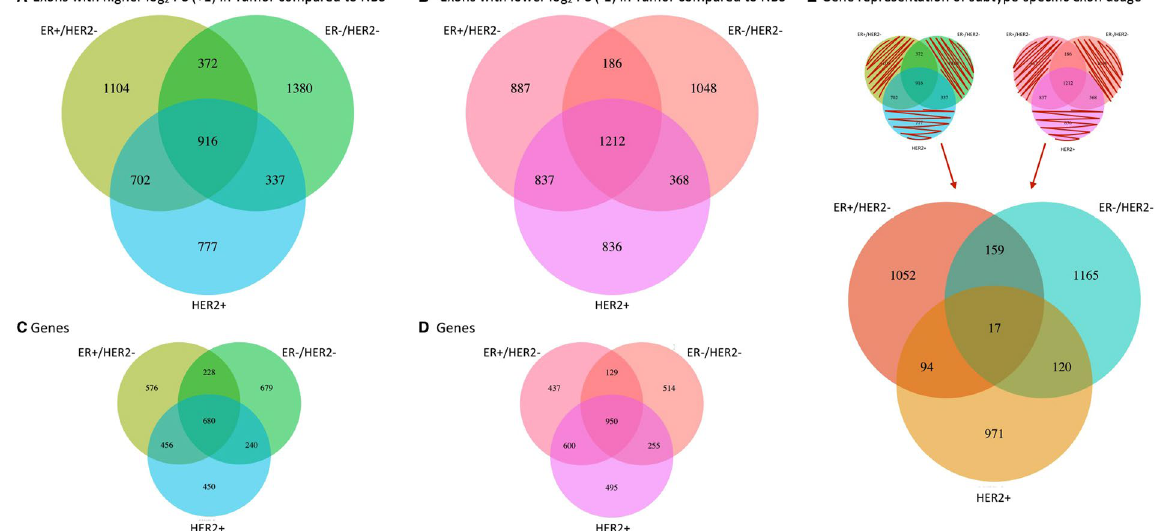
Figure 2. Alternative exon usage in tumor subtypes compared to NBS. The number of exons identified as differentially spliced or transcribed in each tumor class compared to NBS with ( A ) higher FC, and ( B ) lower FC. The number of genes represented by the called exons is shown for each tumor subtype in ( C and D ). Many genes include both higher and lower FC exons. The number of genes representing the exons that are unique to subtype include both genes with differential usage of unique exons in one subtype only, as well as exons with different usage in two subtypes ( + 1 in one subtype, − 1 in another) ( E ). The overlapping genes undergo distinct transcriptional and/or post-transcriptional events of specific exons in a subtype specific manner.